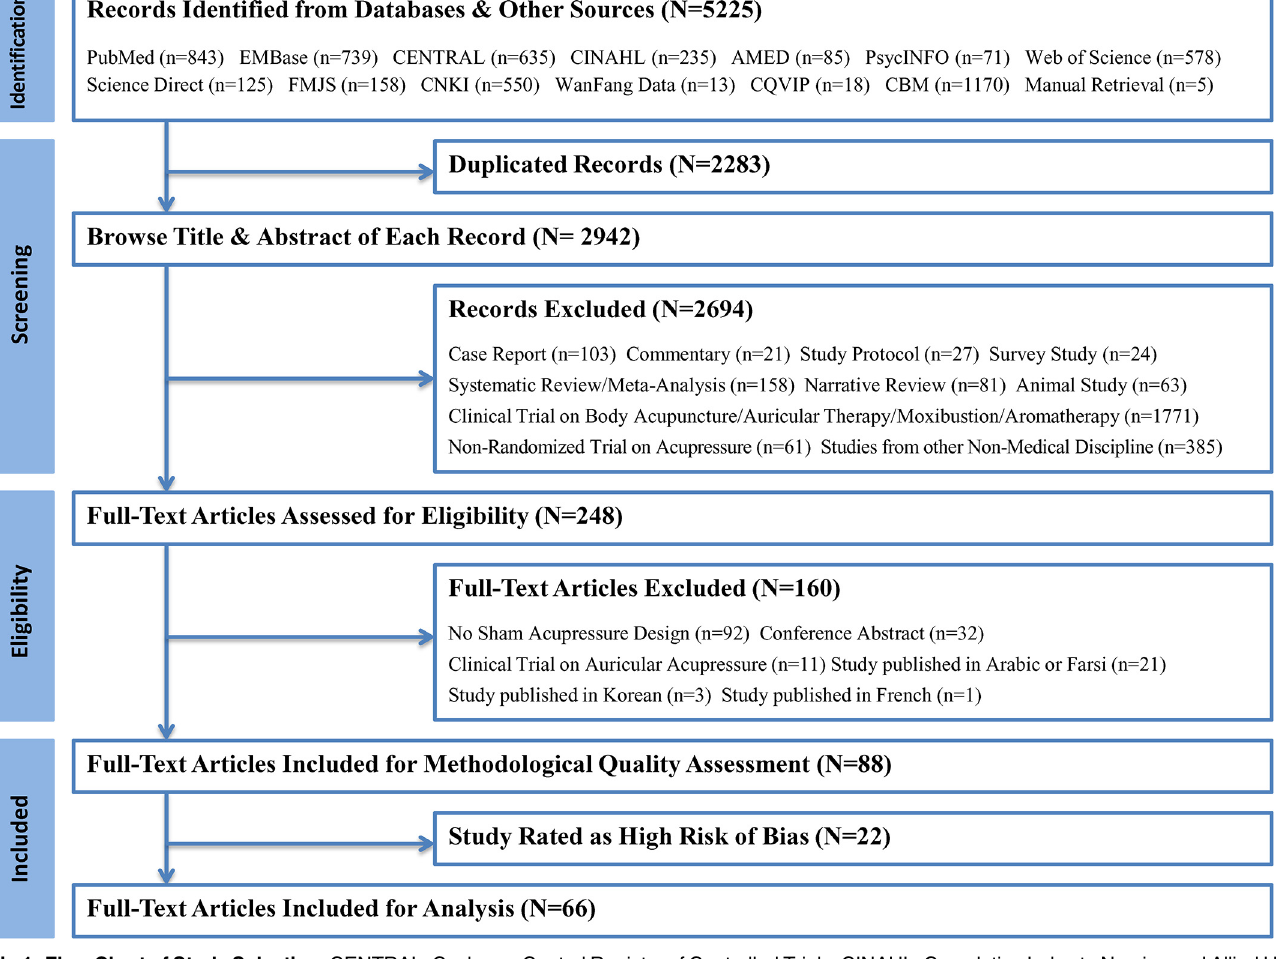
Fig 1. Flow Chart of Study Selection. CENTRAL: Cochrane Central Register of Controlled Trials, CINAHL: Cumulative Index to Nursing and Allied Health Literature, AMED: Allied and Complementary Medicine, FMJS: Foreign Medical Journal Service, CNKI: China National Knowledge Infrastructure, CQVIP: Chinese Scientific Journal Database, CBM: Chinese Biomedical Literature